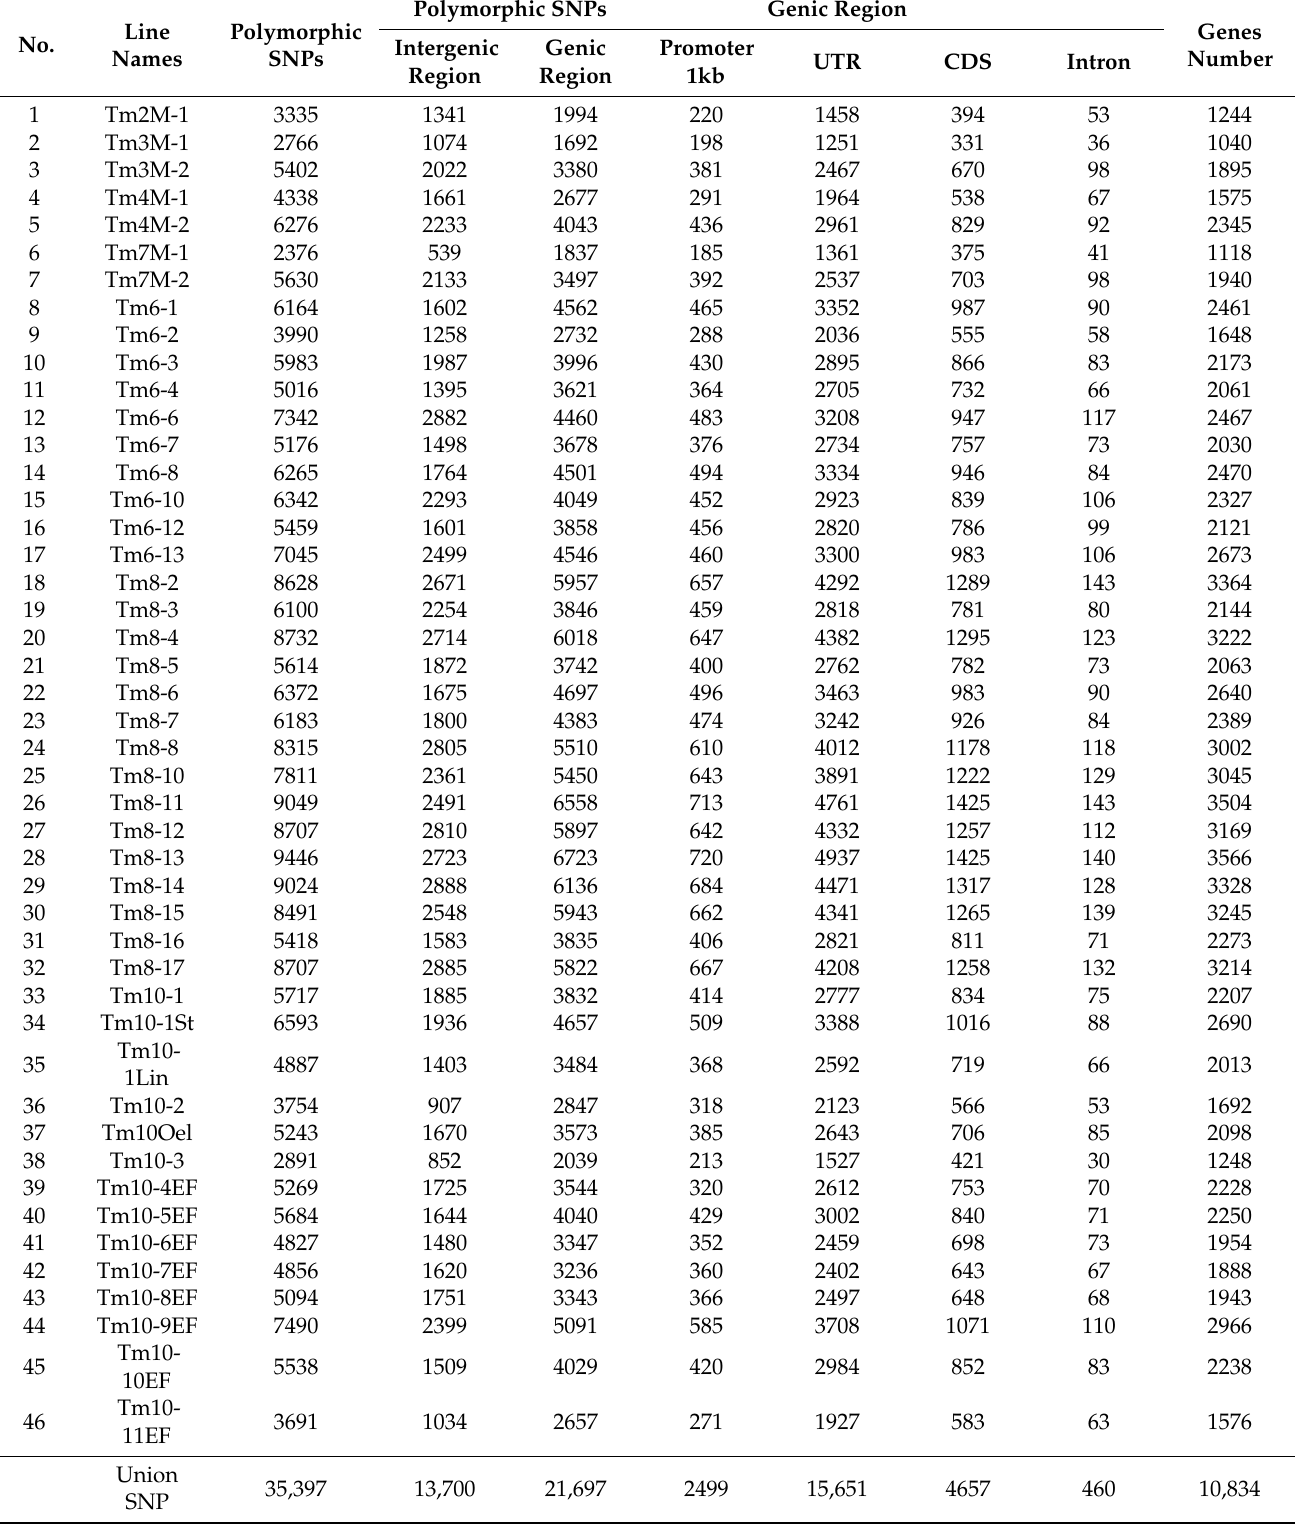
Table 3. Statistics of polymorphic single nucleotide polymorphisms (SNPs) annotation by genomic locations.